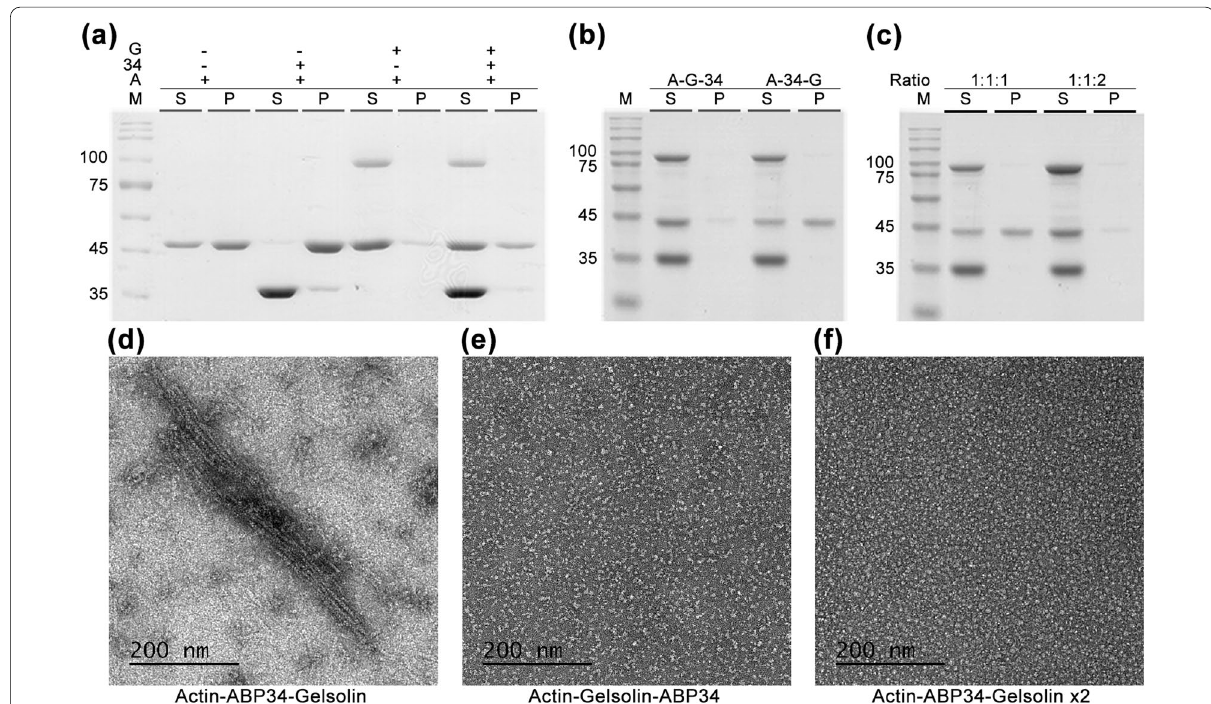
Fig. 2 SDS–PAGE and electron microscopic analysis of co‑sedimentation assay. Co‑sedimentation assay for gelsolin using SDS–PAGE ( a – c ) and negative staining electron microscopy ( d – f ). a General tendency of band migration; actin‑alone, actin actin ABP34 gelsolin (Molar ratio of 1:1:1). b effect of gelsolin treatment on actin‑bundling activity. Gelsolin was treated (molar ratio of 1:1:1) + + before (A‑G‑34, left) and after (A‑34‑G, right) the formation of actin bundles. c Effect of concentration variation (3 μM and 6 μM) of gelsolin on actin‑bundling activity [i.e., two different mixtures of A‑34‑G at different molar ratio of 1:1:1 (left) and 1:1:2 (right)]. S indicates supernatant, while P represents pellet. M, Marker; A, Actin; G, 34, ABP34; G, Gelsolin. d – f Negatively stained fields (at 34,000 nominal magnifications) of F‑actin ABP34 gelsolin mixed at a molar ratio of 1:1:1 ( d ); Actin–gelsolin–ABP34 at 1:1:1 ratio ( e ); and Actin–ABP34–gelsolin 1:1:2 ratio ( f ). Here + + the molecular states were dramatically changed when the molar ratio was modulated to 1:1:2 and depolymerization states of the mixture were visualized in ( f , ( c.f. c)). Scale bars represent 200 nm in each